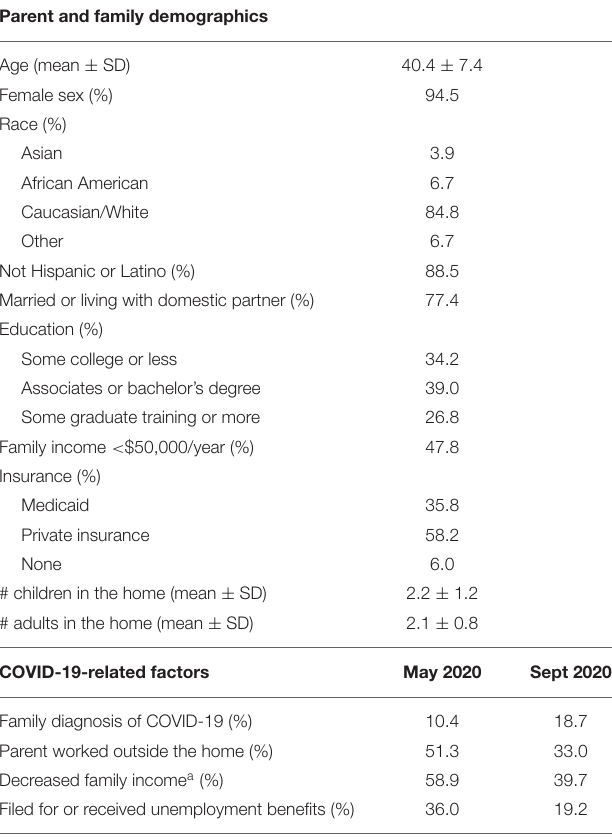
TABLE 1 | Parent and family demographics and COVID-19-related factors in a sample of US parents with a child 5–18 years of age ( N = 433). Parent and family